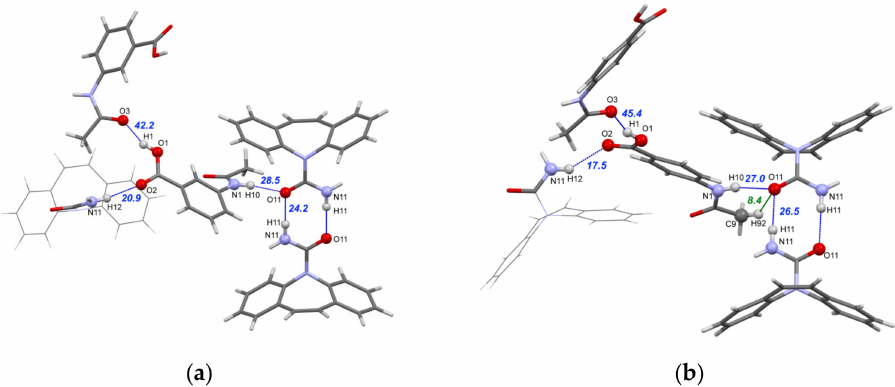
Figure 3. Part of the hydrogen bond network in the [CBZ + 3AcAmBA] (1:1) cocrystal ( a ) and in the [CBZ + 4AcAmBA] (1:1) cocrystal ( b ). The energies denote the interaction energies of conventional (blue dotted lines) and non-conventional H-bonds (green dotted lines), estimated using Equation (2) in kJ · mol − 1